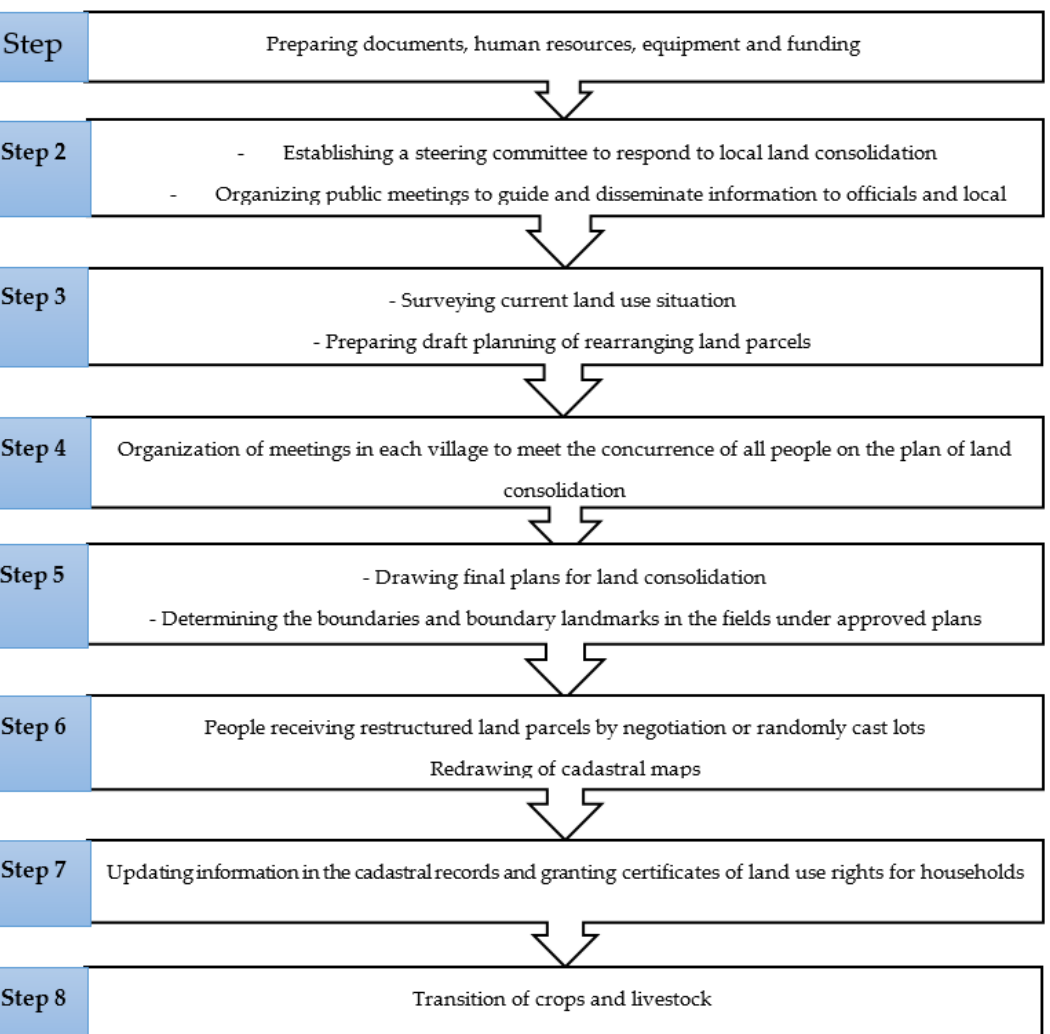
Figure 2. Process of regrouping land and crops and livestock conversion in land consolidation (drawn by the authors).